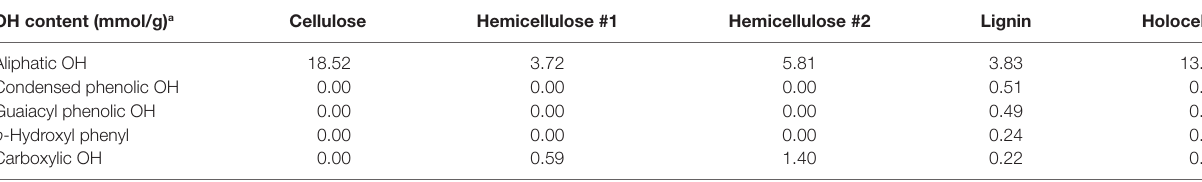
TaBle 1 | Hydroxyl group contents of cellulose, hemicellulose, holocellulose, and lignin. Oh content (mmol/g) a